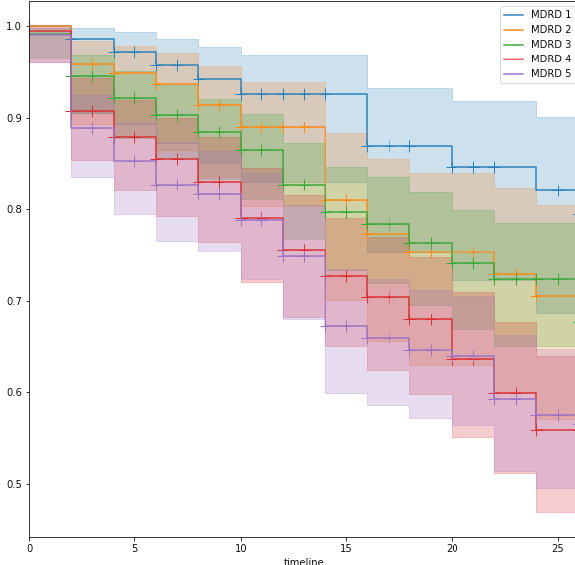
Fig. 3. Kaplan-Meier curves for 28 days all cause mortality of Czech patients according admission BUN level. group comparison by log-rank test, P <0.01